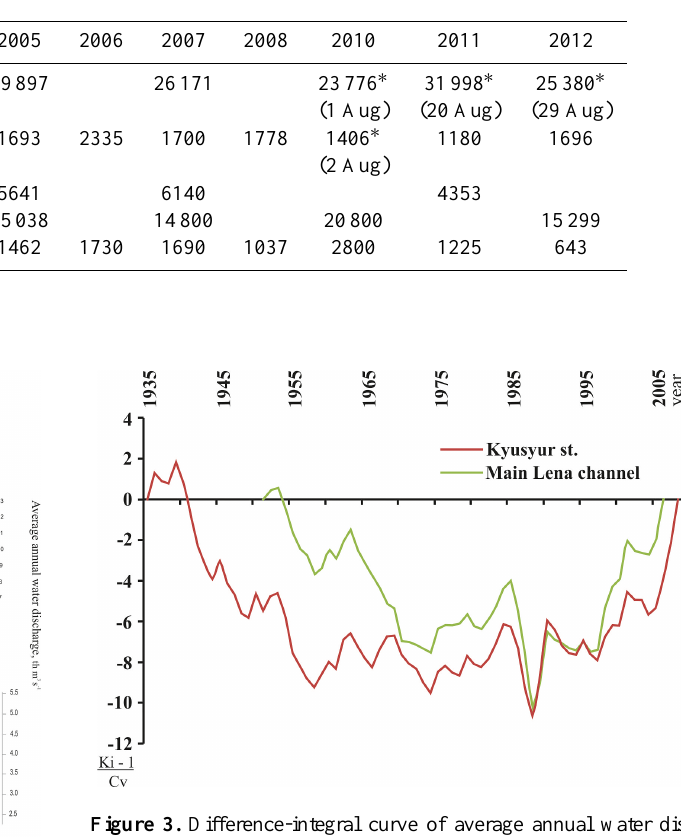
Table 1. Measured discharge Q (m 3 s − 1 ) for the main branches. All discharges have been calculated normalized to one water level, equal to 365cm at the Bykovskaya branch water gauge at Khabarova.